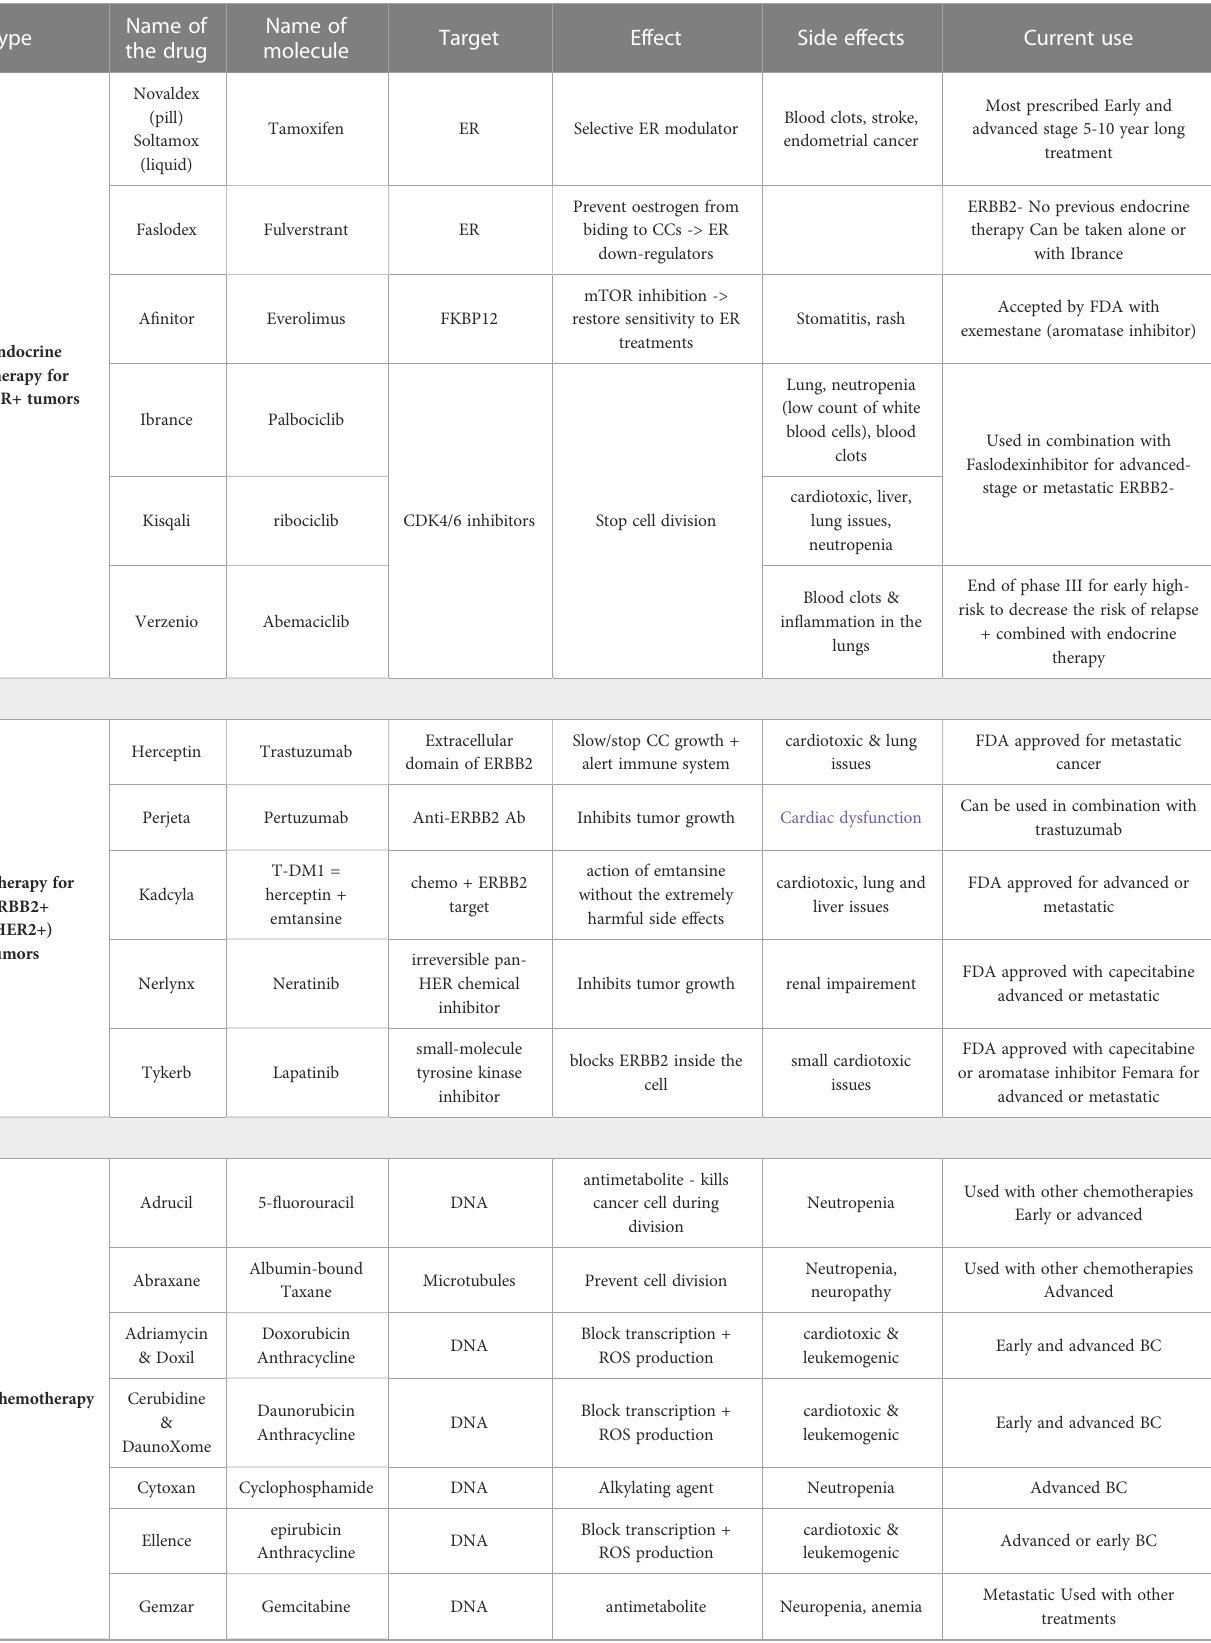
TABLE 1 Classi fi cation of currently available drugs targeting different breast cancer